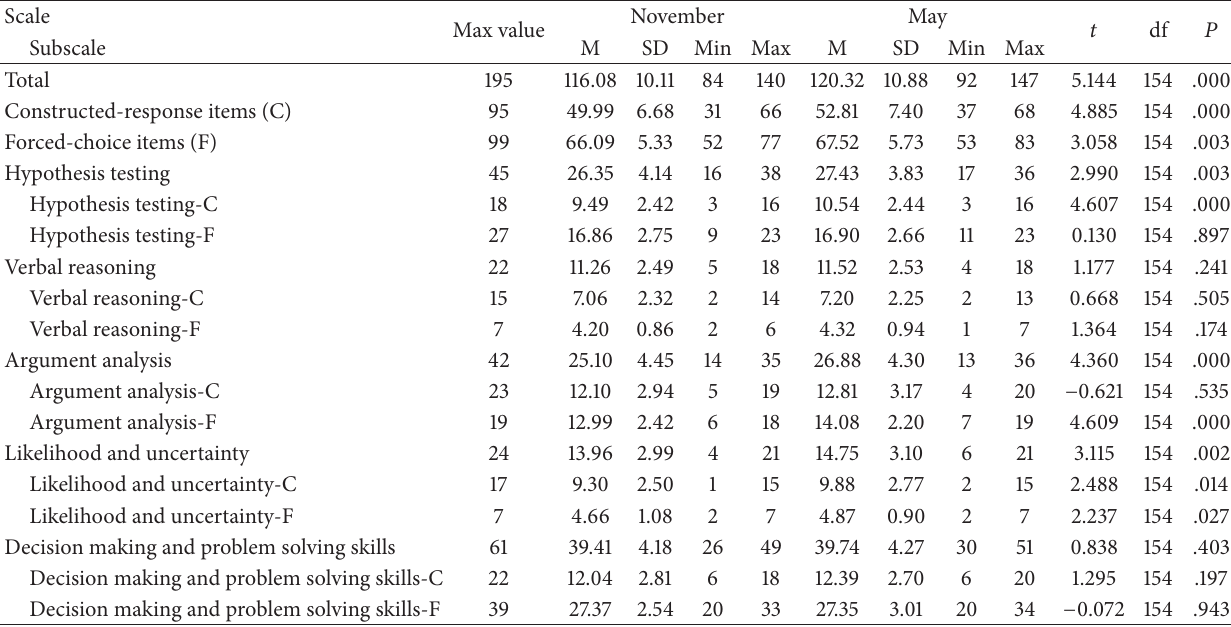
Table 2: Descriptive statistics for the HCTA ( 𝑁 = 155 ).